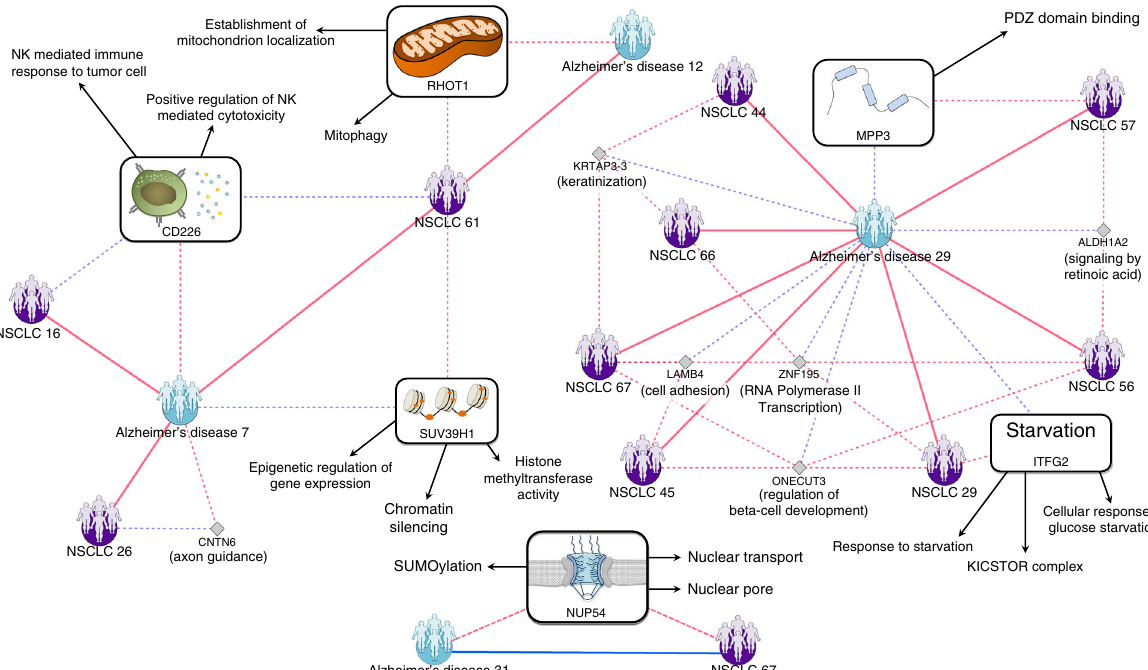
Fig. 5 Molecular bases of the Alzheimer ’ s disease — non-small-cell lung cancer comorbidity relations. Positive and negative Relative Molecular Similarity (pRMS and nRMS) interactions between Alzheimer ’ s disease and non-small-cell lung cancer subgroups composed by at least four patients with shared genes (extracted from the Strati fi ed Comorbidity Network). Each node represents a patient-subgroup. Red and blue edges represent negative and positive interactions respectively. Solid lines represent interactions between subgroups while dashed lines represent patient-subgroup — gene/pathway interactions. Only those genes (and pathways; see “ Methods ” ) associated to positively or negatively connected patient-subgroups are shown (see “ Methods ”